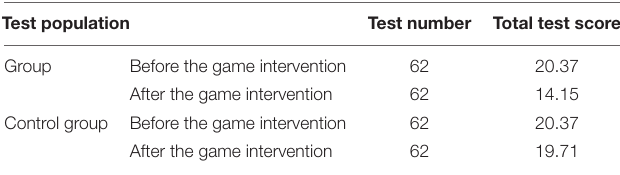
TABLE 4 | Comparison of the Test Anxiety Scale (TAS) scores before and after the Sand Table game intervention. Test